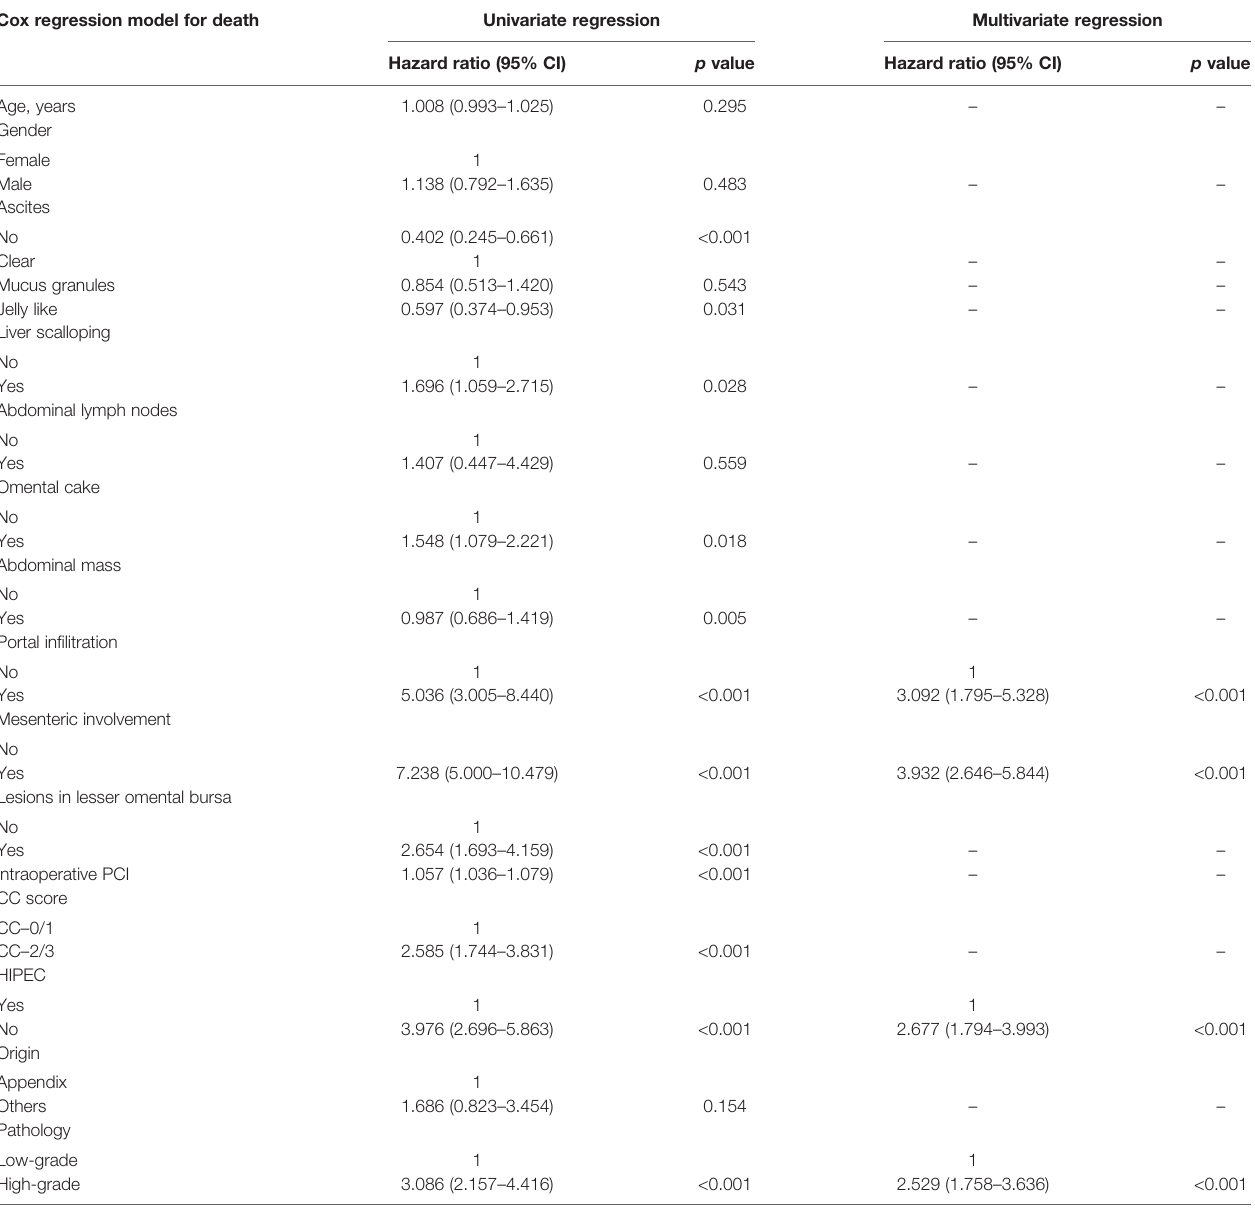
TABLE 5 | The Cox regression model with US